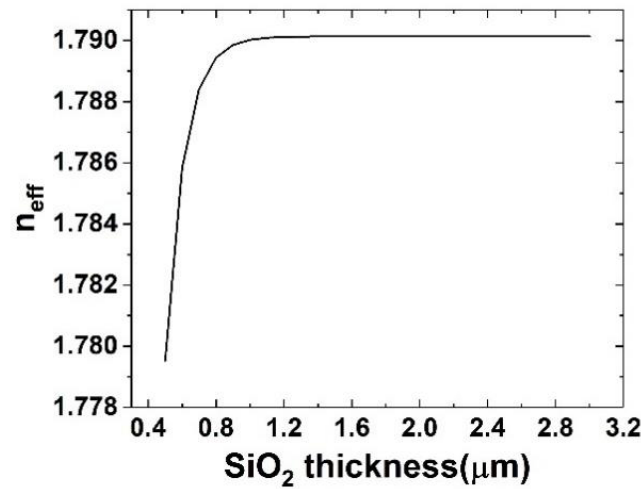
Figure 4. Relationship between the SiO 2 thickness and the effective refractive index.